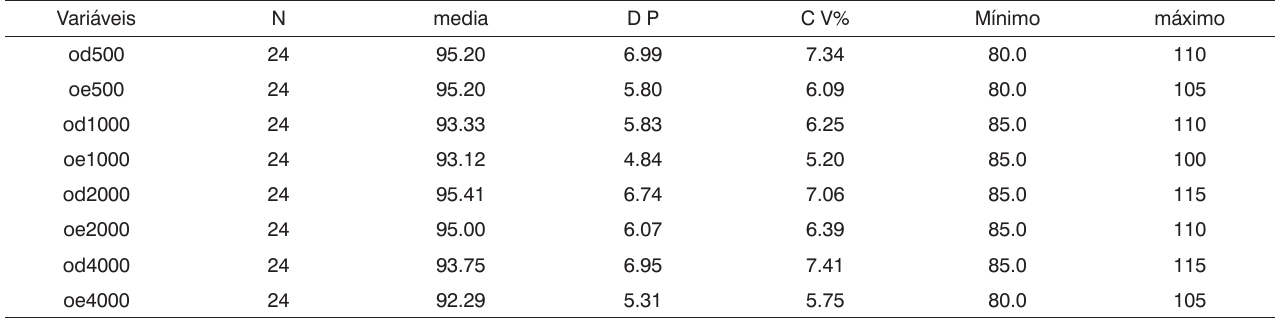
Tabela 3. Análise dos limiares do reflexo acústico contralateral para o gênero feminino.